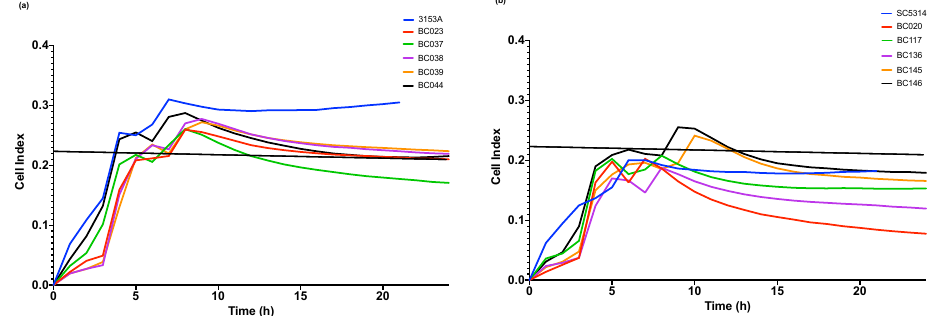
Figure 2. Growth profile as shown by xCELLigence system. Data represent the mean of normalized cell index values taken every 30 min over 24 h of ( a ) C. albicans 3153A and five LBFs ( b ) C. albicans SC5314 and five